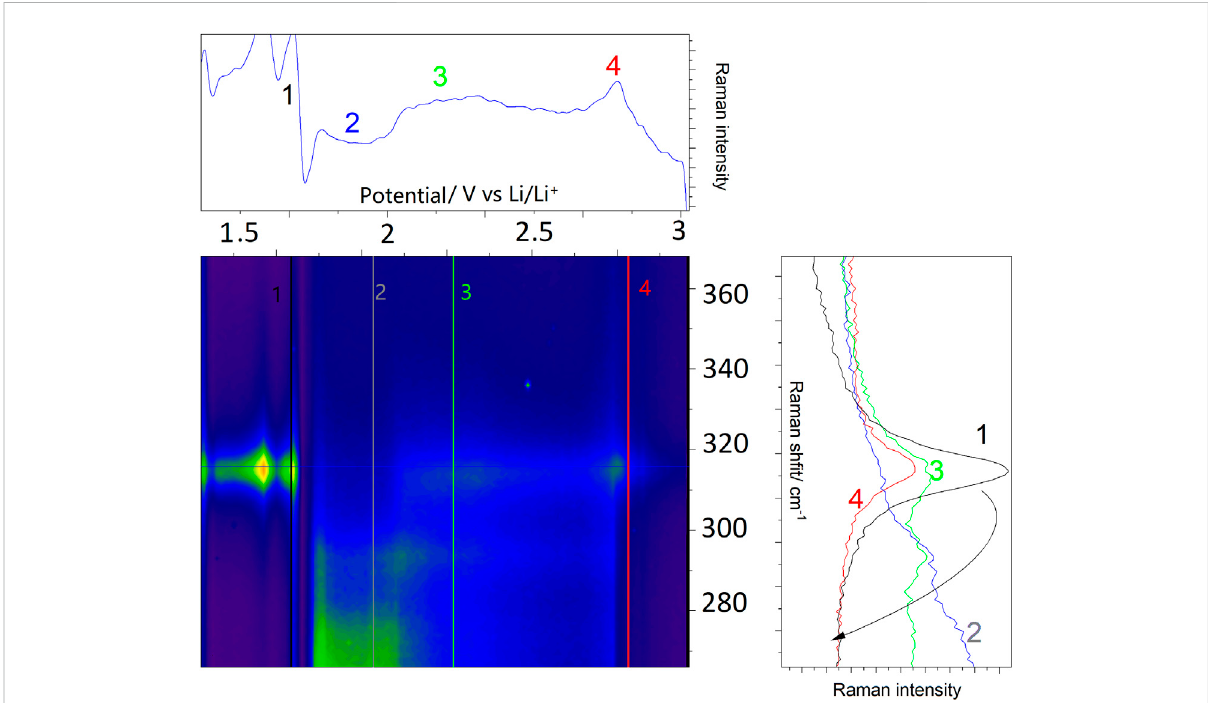
FIGURE 5 Operando Raman spectroelectrochemistry during lithiation of 2D SnS 2 . The right panel shows consecutive steps during 2D SnS 2 lithiation. Colored numbers refer to the potentials, at which the Raman spectra were acquired and correspond to the vertical lines in the central contour. The intensity changes at 1.65 V result from an intermediary loss/recovery of laser focus. For details see text.